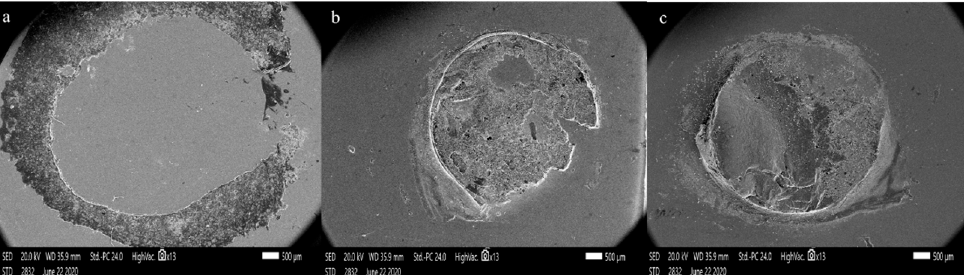
Figure 10. SEM images of different modes of failure of debonded specimens X13; ( a ) adhesive failure in Group D, ( b ) mixed adhesive cohesive failure in a Group A, and ( c ) is a mixed adhesive cohesive failure with a cohesive fracture in Group B.